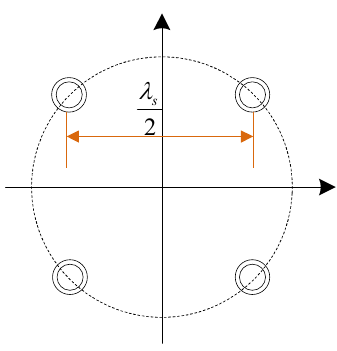
Figure 3. The antenna array configuration. ( λ s represents the signal wavelength). Table 1. Basic simulation parameters.